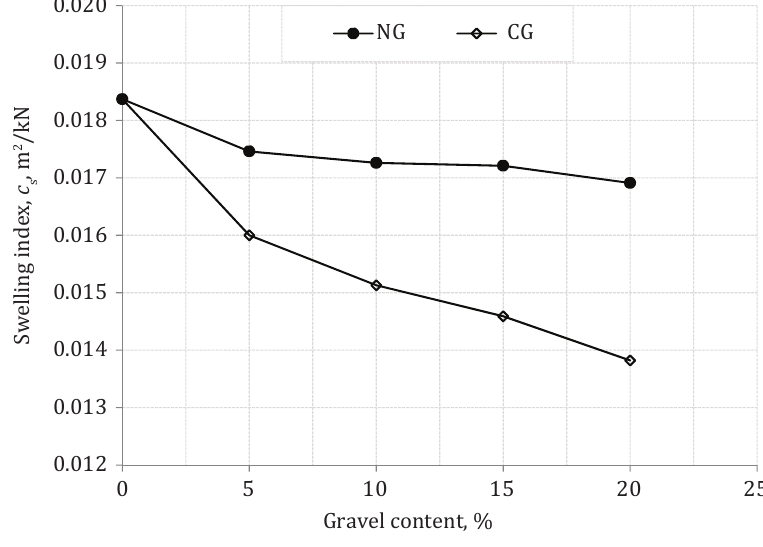
Figure 12. Variation of c s in the clay with NG and